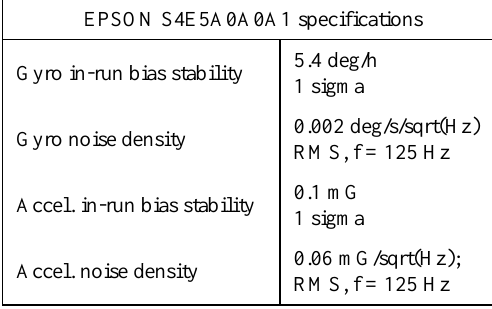
Table 3: Specifications for the EPSON